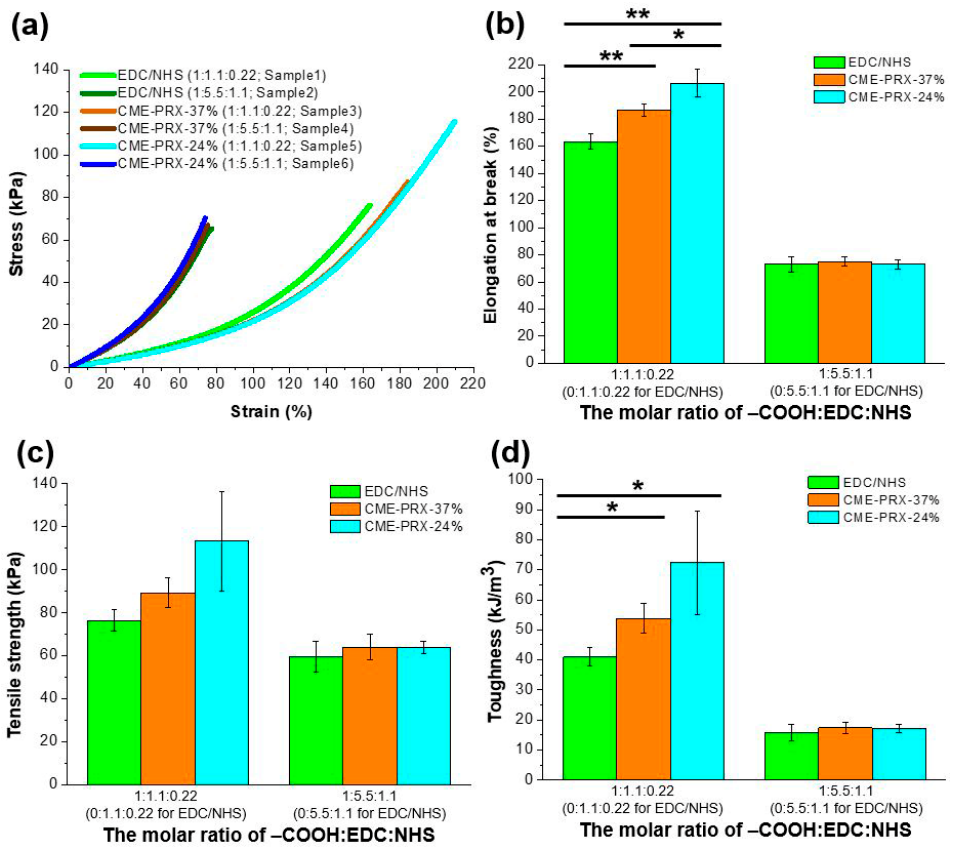
Figure 4. ( a ) Stress–strain curves of gelatin hydrogels cross-linked by CME-PRXs; ( b ) Elongation; ( c ) tensile strength; ( d ) toughness of gelatin hydrogels cross-linked by CME-PRXs (* p < 0.05 and ** p < 0.01; n = 3).